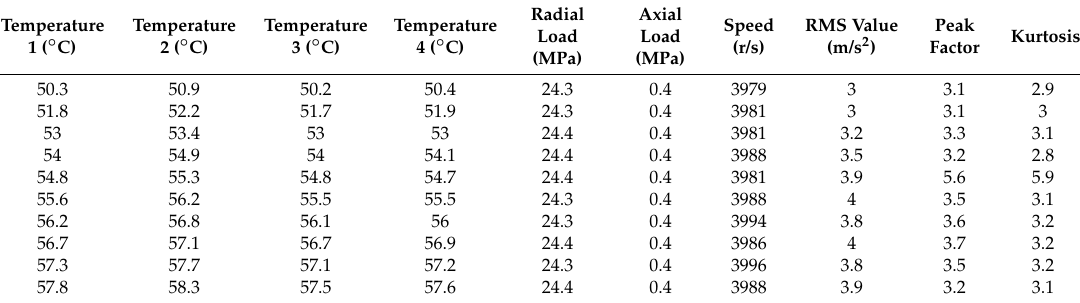
Table 2. Part data of the test machine status during grinding of bearings.